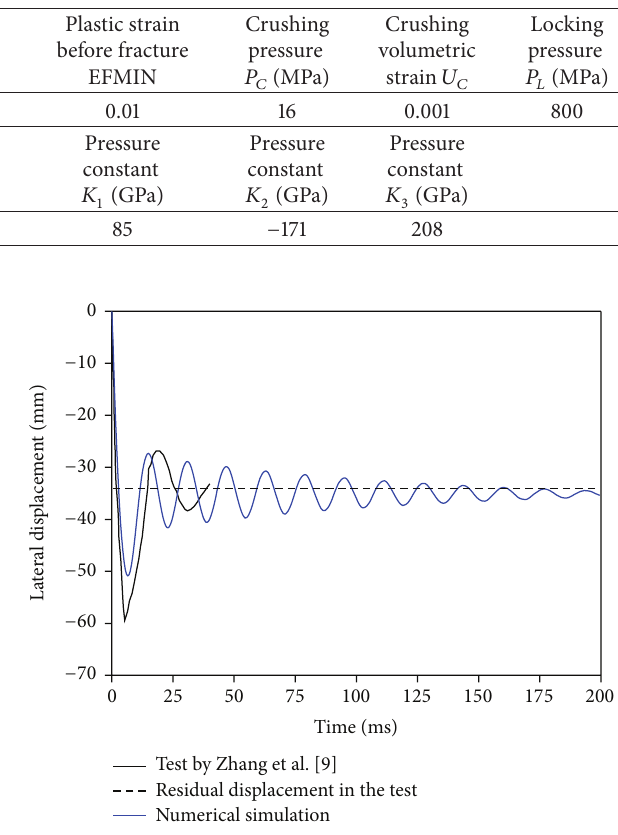
Figure 4: Comparison of the displacement data from test and that of numerical